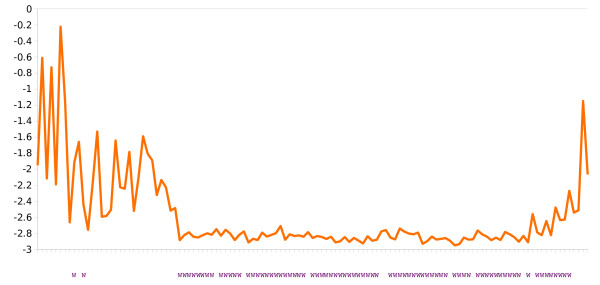
A plot of residue entropy against the optimal sequence for CASP target T0171. Here the relative entropy is plotted against the optimal sequence of query T0171. Relative entropy is calculated from the alignments from the final iteration of the PSI-BLAST search of the Combined-nr database. The optimal sequence is drawn from the PSI-BLAST profile of the same target. Notice that the entropy flattens out and that this region of low entropy and low conservation coincides with the long stretch of repeated tryptophans in the optimal sequence. Entropy is shown on log scale.